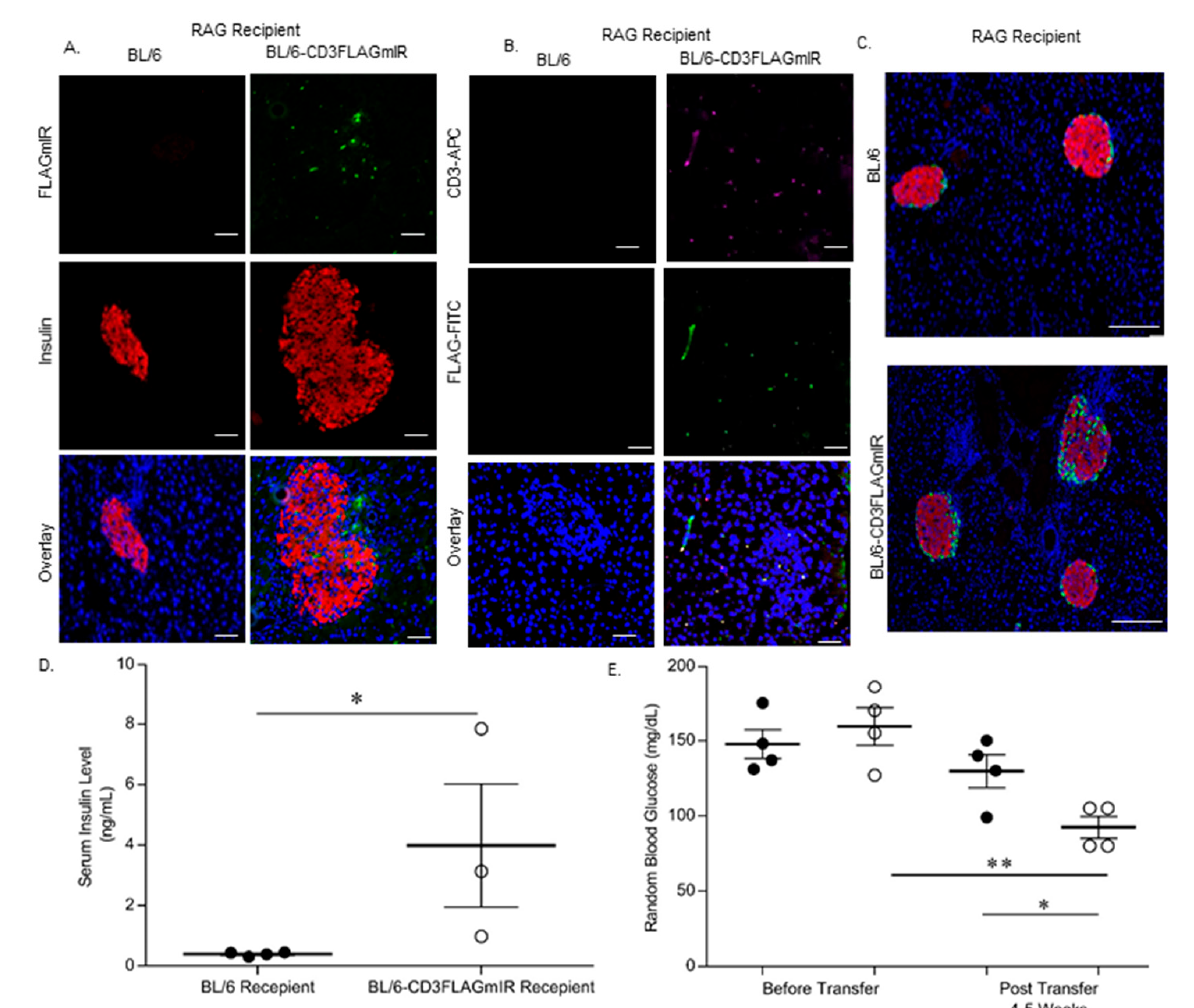
Figure 13. Adoptive transfer of whole splenocytes from either BL/6-CD3FLAGmIR mice, BL/6 mice, or vehicle PBS into C57BL/6 RAG − / − mice. ( A ) Immunofluorescence staining of RAG − / − recipient mice islets stained for insulin (Red), FLAG expressing T cells (Green), and DAPI for nuclei (Blue). Scale bar: 100 µ m. ( B ) Immunofluorescence staining of pancreatic tissue stained with anti-CD3 (magenta) and anti-FLAG (Green) to demonstrate the presence of FLAGmIR + T cells in the recipient mice islets. Scale bar: 100 µ m. ( C ) Immunofluorescence staining of BL/6 and BL/6-CD3FLAGmIR recipient islets for insulin (Red) and glucagon (green). Scale bar: 300 µ m. ( D ) Non-fasting serum insulin levels of recipient RAG − / − mice at 5 weeks post-transfer of either BL/6 splenocytes (black circle), or BL/6-CD3FLAGmIR splenocytes (white circle). Each dot represents an individual mouse. Mann–Whitney test, * p ≤ 0.05. ( E ) Random blood glucose levels from recipient mice before and post-transfer with BL/6 splenocytes (black circle) or BL/6-CD3FLAGmIR transgenic splenocytes (white circle). Each dot represents an individual mouse. One-way ANOVA followed by Tukey’s multiple comparison test * p ≤ 0.05, ** p ≤ 0.01.